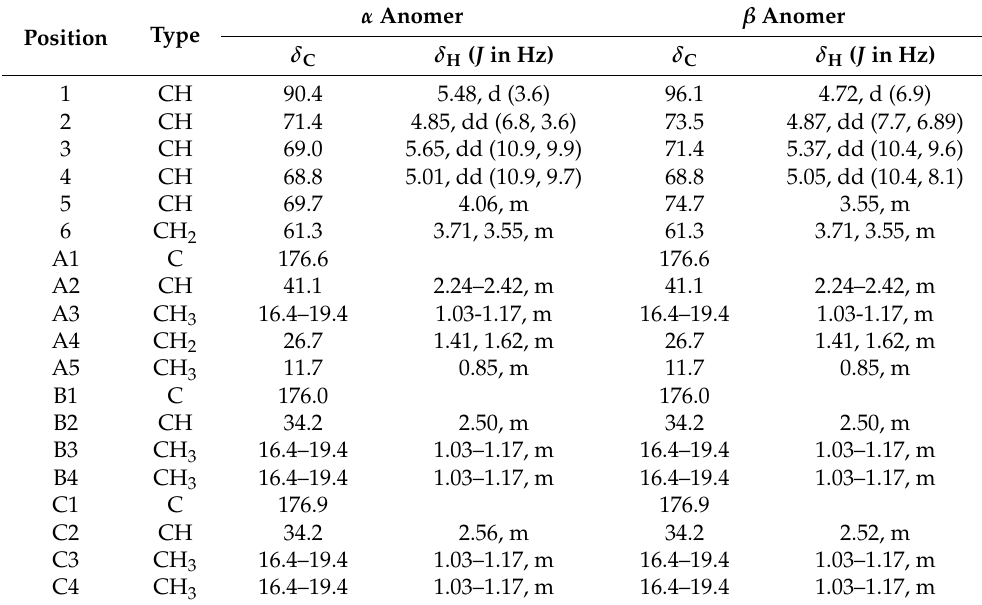
Table 3. 1 H NMR (500 MHz) and 13 C NMR (126 MHz) spectroscopic data of synthesized ( S ) isomer of pennelliiside D ( 1 ) in CDCl 3 ( δ in ppm, J in